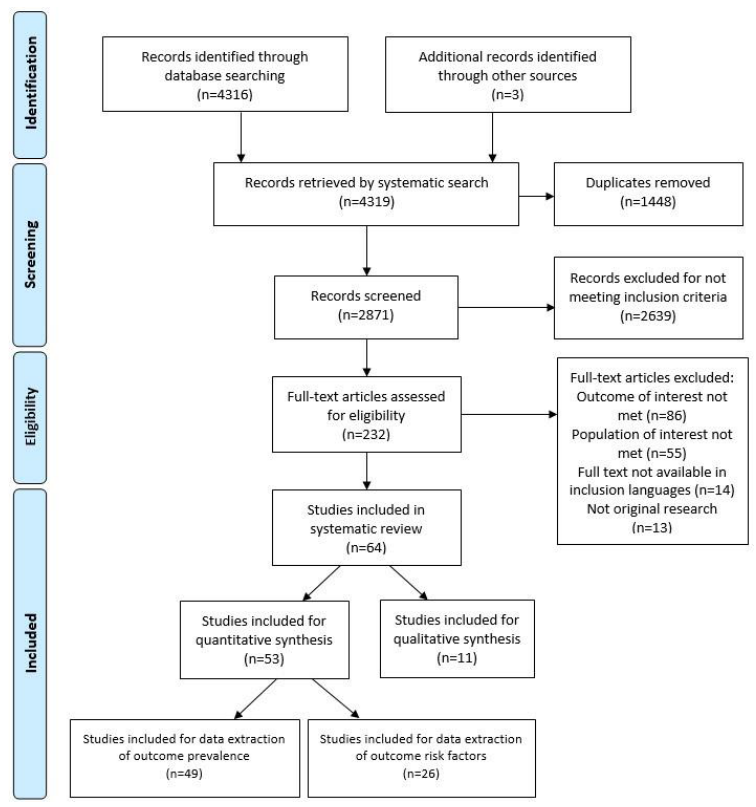
Figure 1. Preferred reporting items for systematic reviews and meta-analyses (PRISMA) flow diagram of studies identified and included for qualitative and quantitative synthesis of studies investigating working equid lameness in low- and middle-income countries, published from 2003 to 2021.